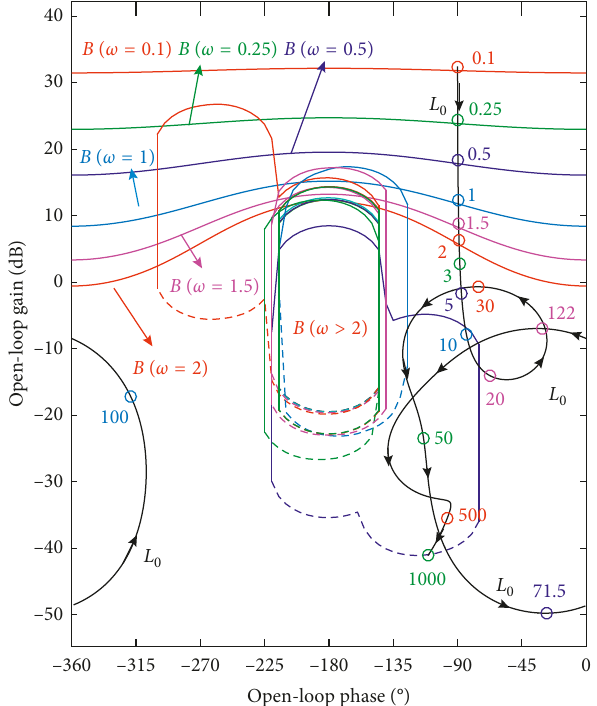
Figure 3: The nominal loopshaping plot for a fault-free system. B ( ω ) denotes the bounds at each design frequency ω . Figure